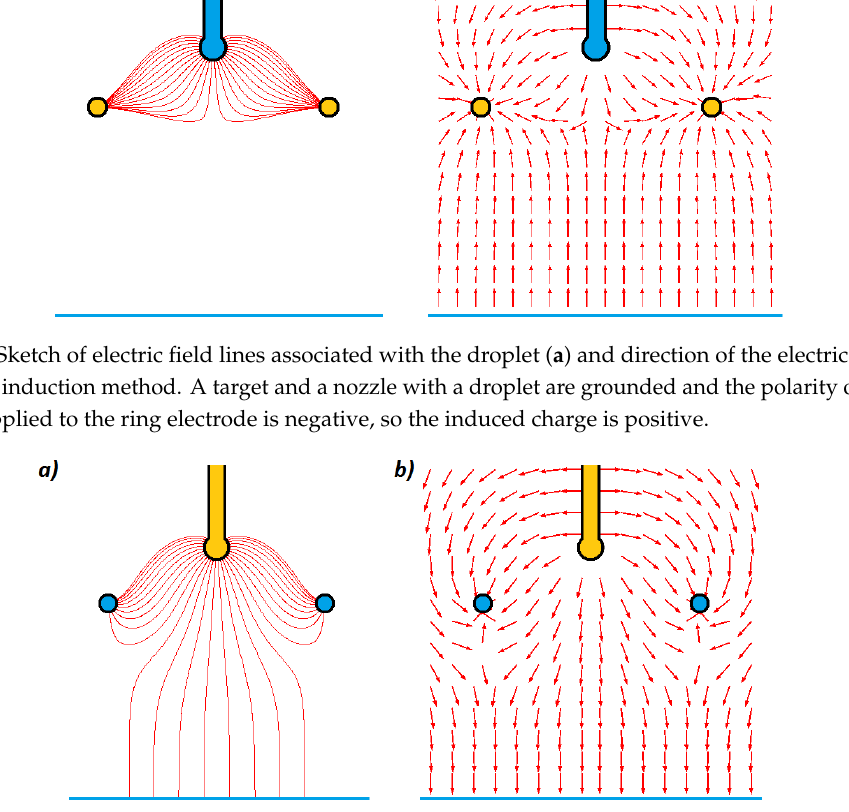
Figure 5. Sketch of electric field lines associated with the droplet ( a ) and direction of the electric field ( b ) for the conduction method. A ring electrode and a target are grounded and the polarity of the voltage applied to the droplet is positive, so the induced charge is also positive.